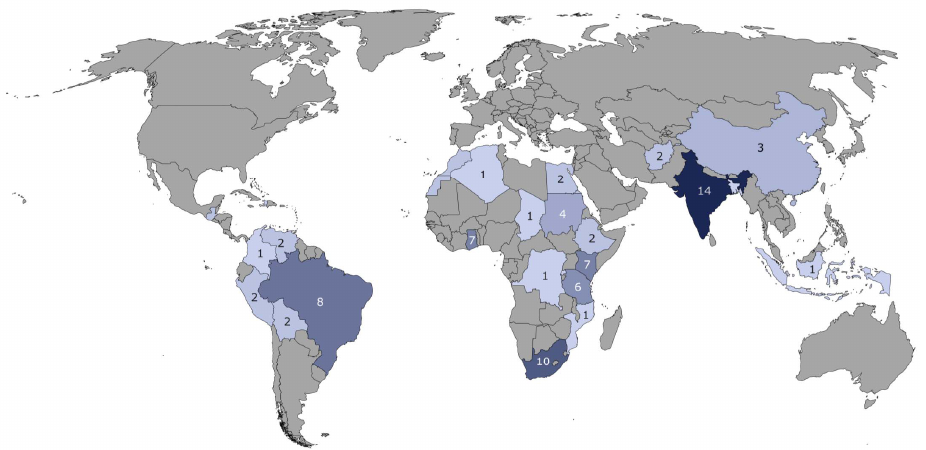
Figure 1. Visualization of the number of studies on slum identification by remote sensing data. We used data from Mahabir et al. [29] to create the